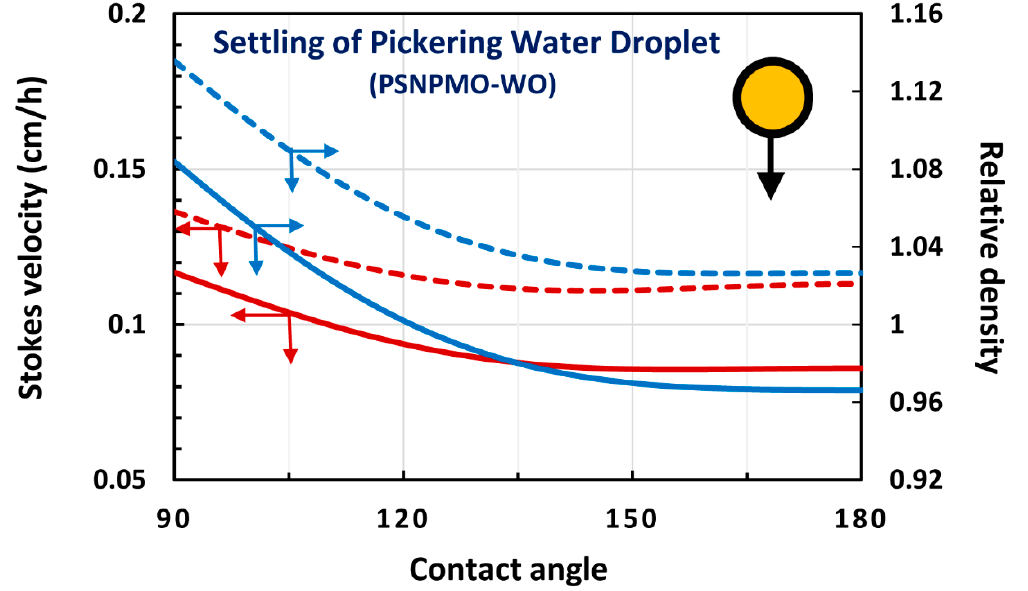
Figure 16. Variations of Stokes settling velocity and relative density of a single Pickering water droplet with contact angle (PSNPMO-WO Pickering emulsion). The solid curves represent square packing and the dashed curves represent hexagonal packing of nanoparticles at the oil-water interface.